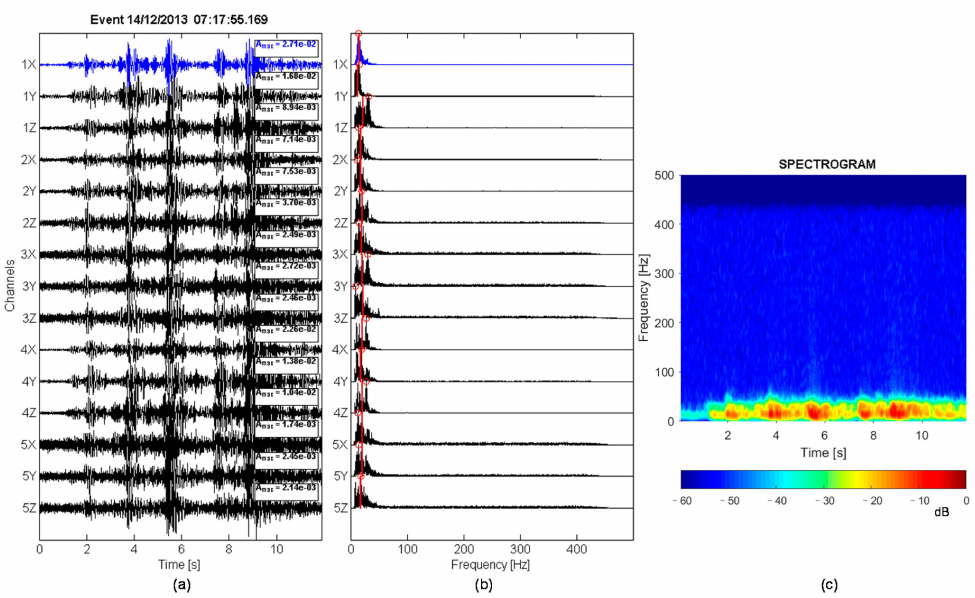
Figure 3. Example of MS events related to a reported rockfall. ( a ) Signals recorded by 15 channels. ( b ) Fourier spectra. ( c ) Spectrogram generated by stacking the spectrograms of all